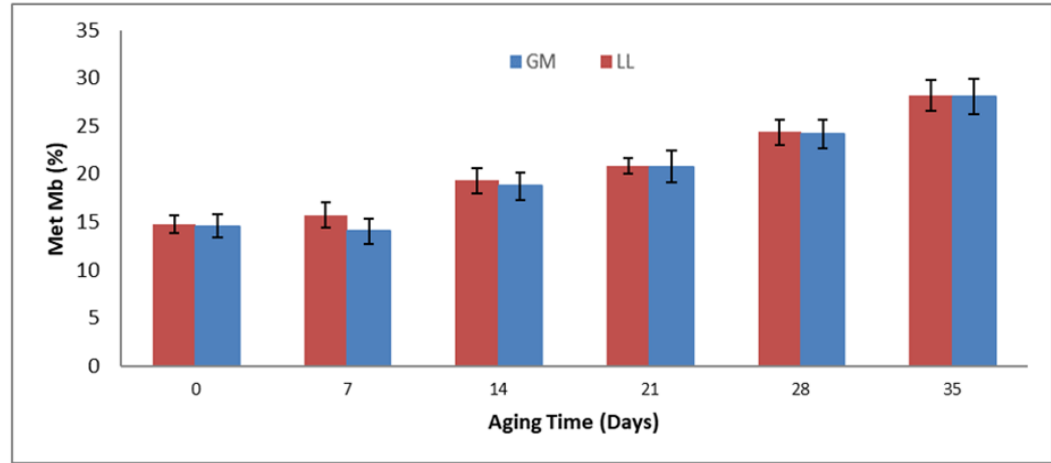
Figure 2. Effects of aging time and muscle type on Metmyoglobin% of buffalo meat.